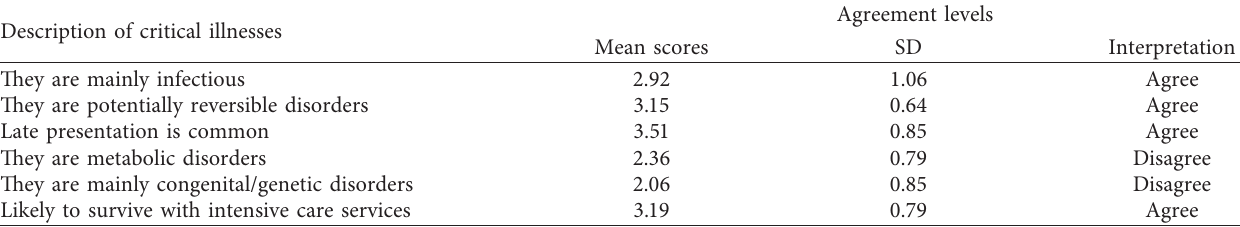
Table 3: Participant’s agreement with description of critical illnesses seen in the preceding 3 weeks.